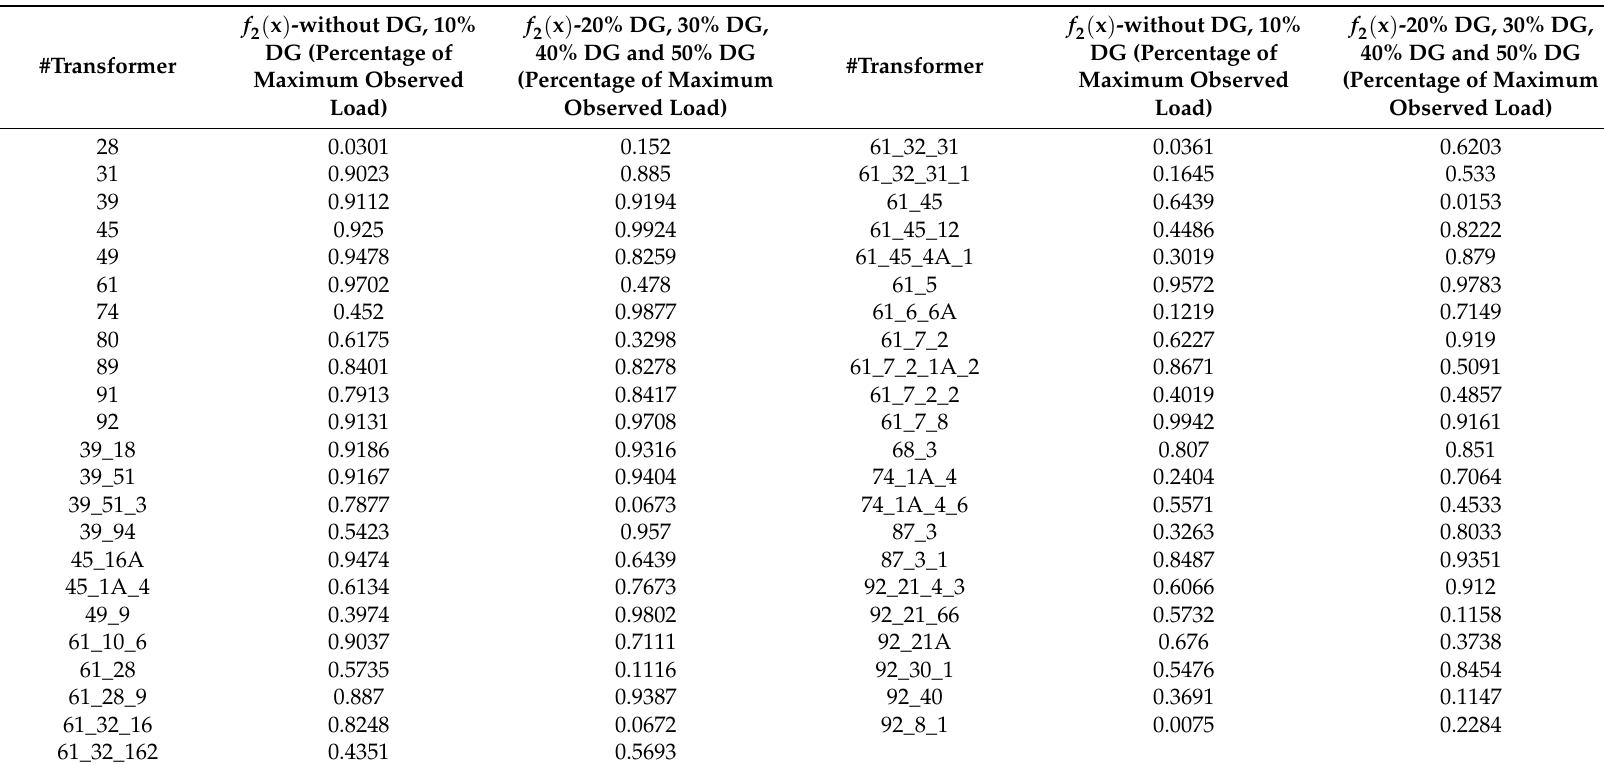
Table 3. Optimal loading per node according to f 2 ( x ) for increasing production up to 50% of the distributed generator’s installed capacity.